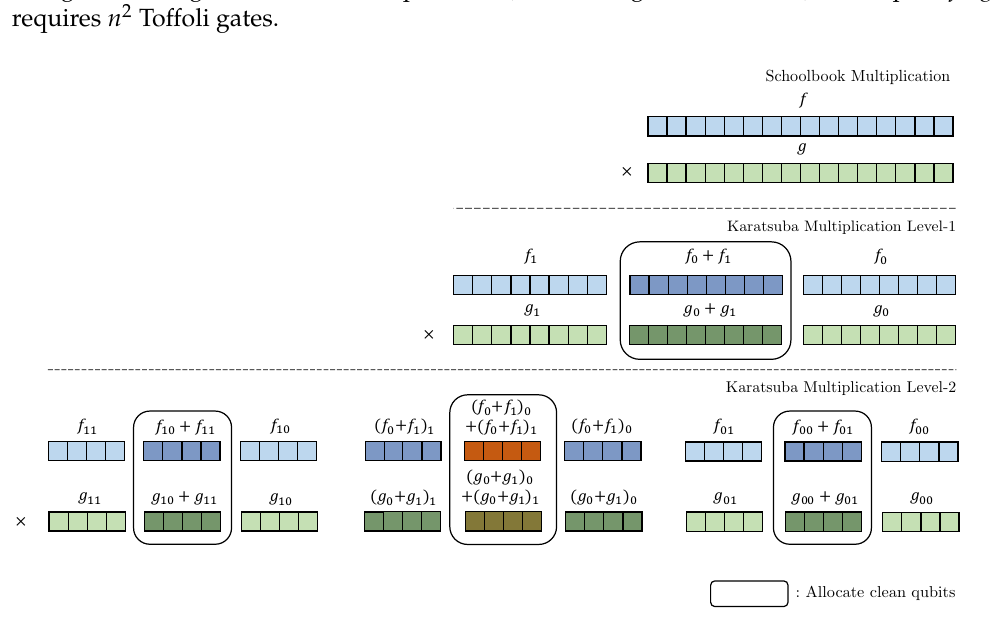
Table 1. Quantum resources required for multiplication